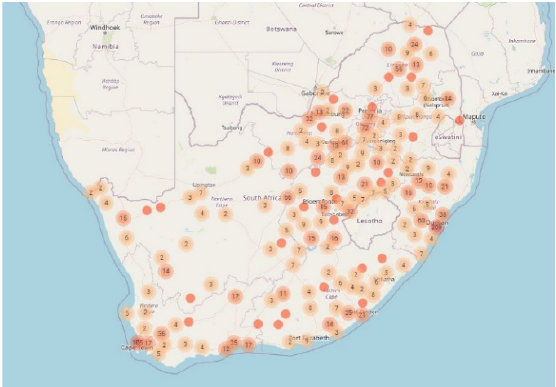
Figure 9: Map of all recordings submitted to KoBoToolbox